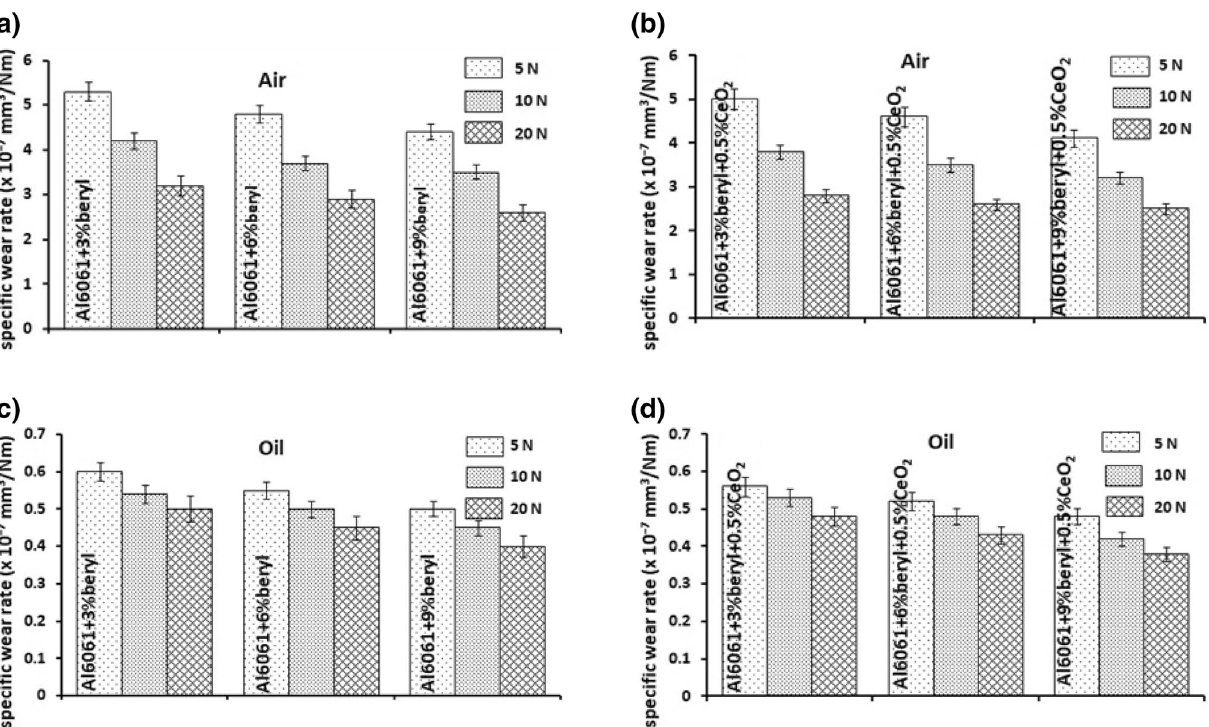
Fig. 8 Specific wear rate of “Al6061–Beryl” and “Al6061–Beryl–CeO